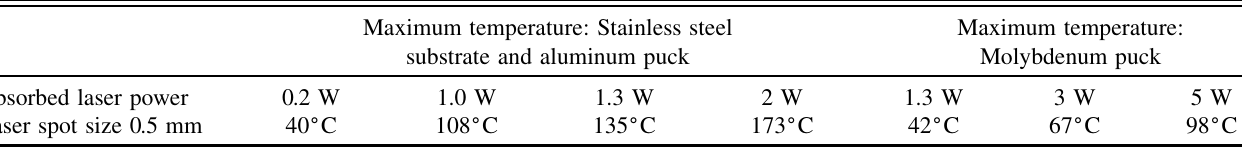
TABLE I. Maximum simulated temperature at the illuminated location for a given absorbed laser power for our CsSb = stainless steel = aluminum puck as well as a K2CsSb = molybdenum puck. K 2 Maximum temperature: Stainless